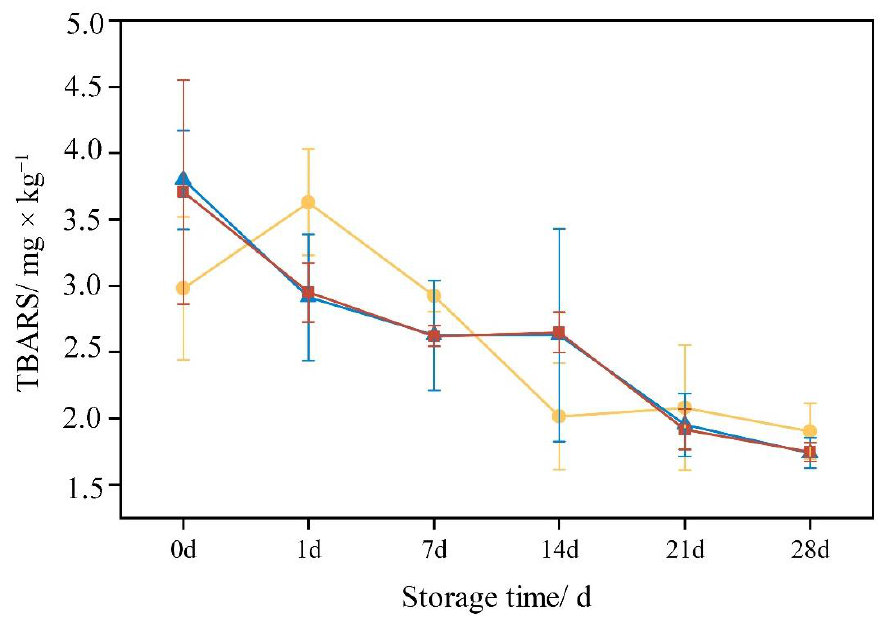
Figure 6. Variation trend of TBARS value during storage of lamb liver paste. Note: yellow represents the natural fermentation group (NF); blue represents the starter fermentation group (SF); red represents the sterilization group (ST).